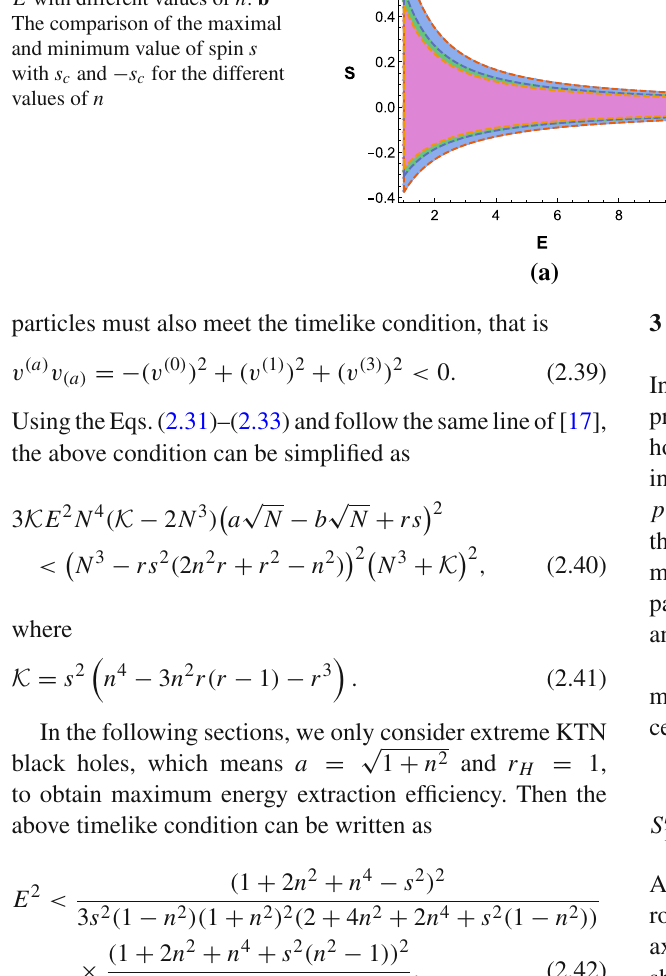
Fig. 1 a The timelike condition region for the spin s and energy E with different values of n . b The comparison of the maximal and minimum value of spin s with s c and − s c for the different values of n